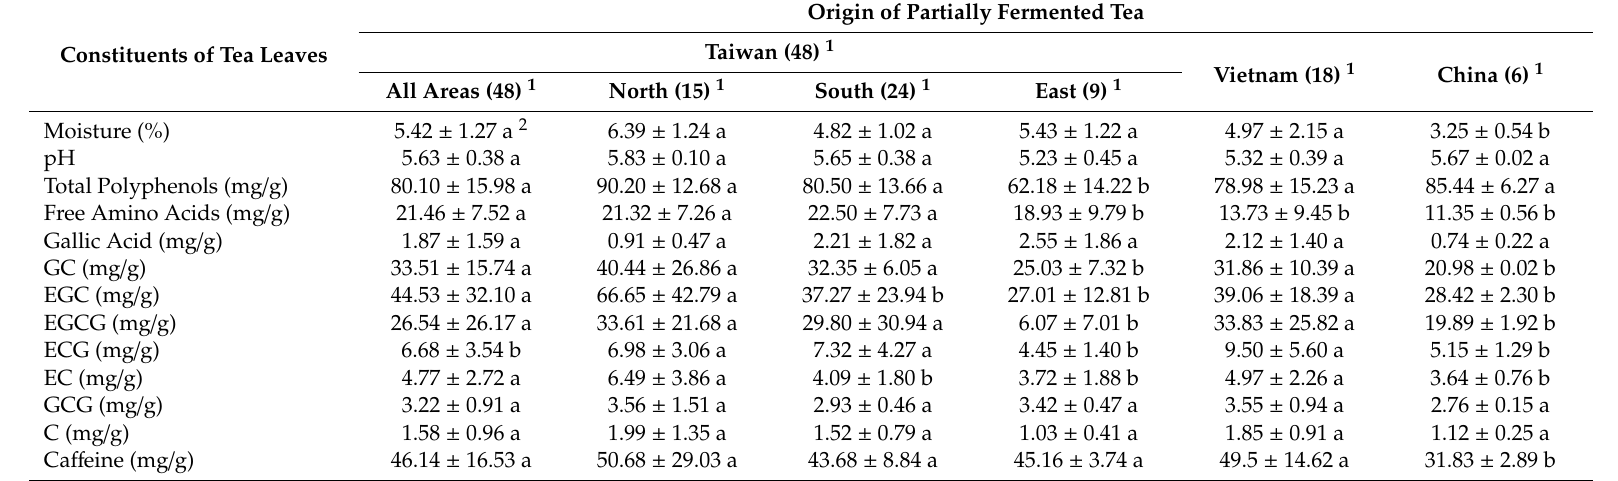
Table 3. Concentrations of constituents in the partially fermented teas from Vietnam, China, and di ff erent production areas in Taiwan (northern, southern, and eastern